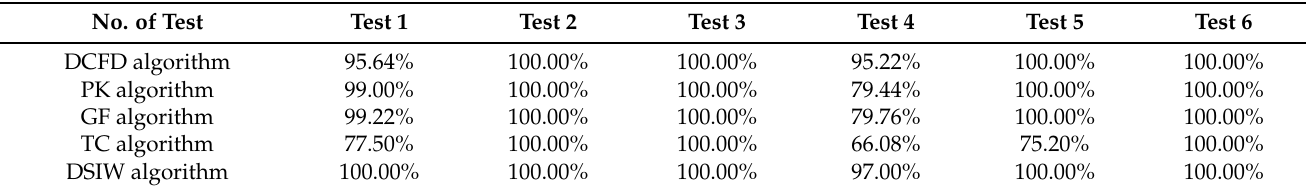
Table 3. Ranging success rates of the algorithms.